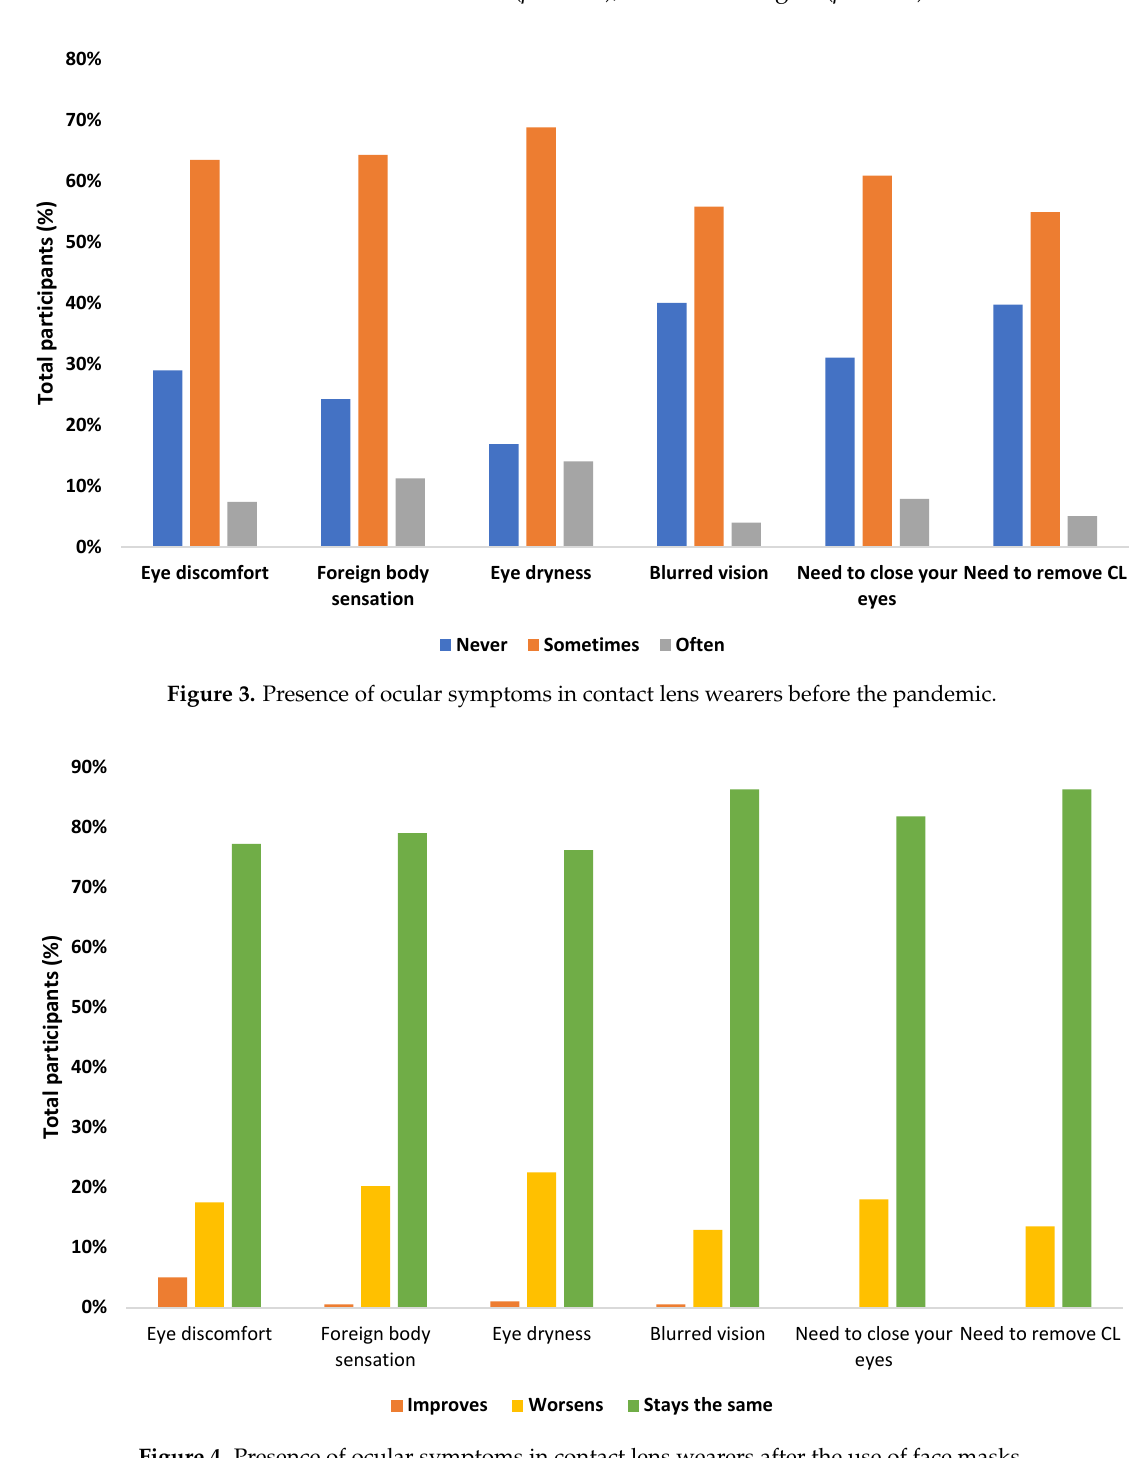
Figure 4. Presence of ocular symptoms in contact lens wearers after the use of face masks.